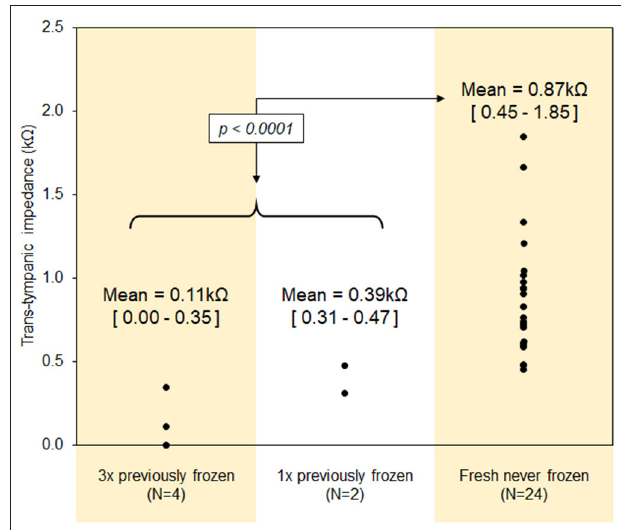
FIGURE 3 | Trans-tympanic impedance characteristics of the human tympanic membrane.